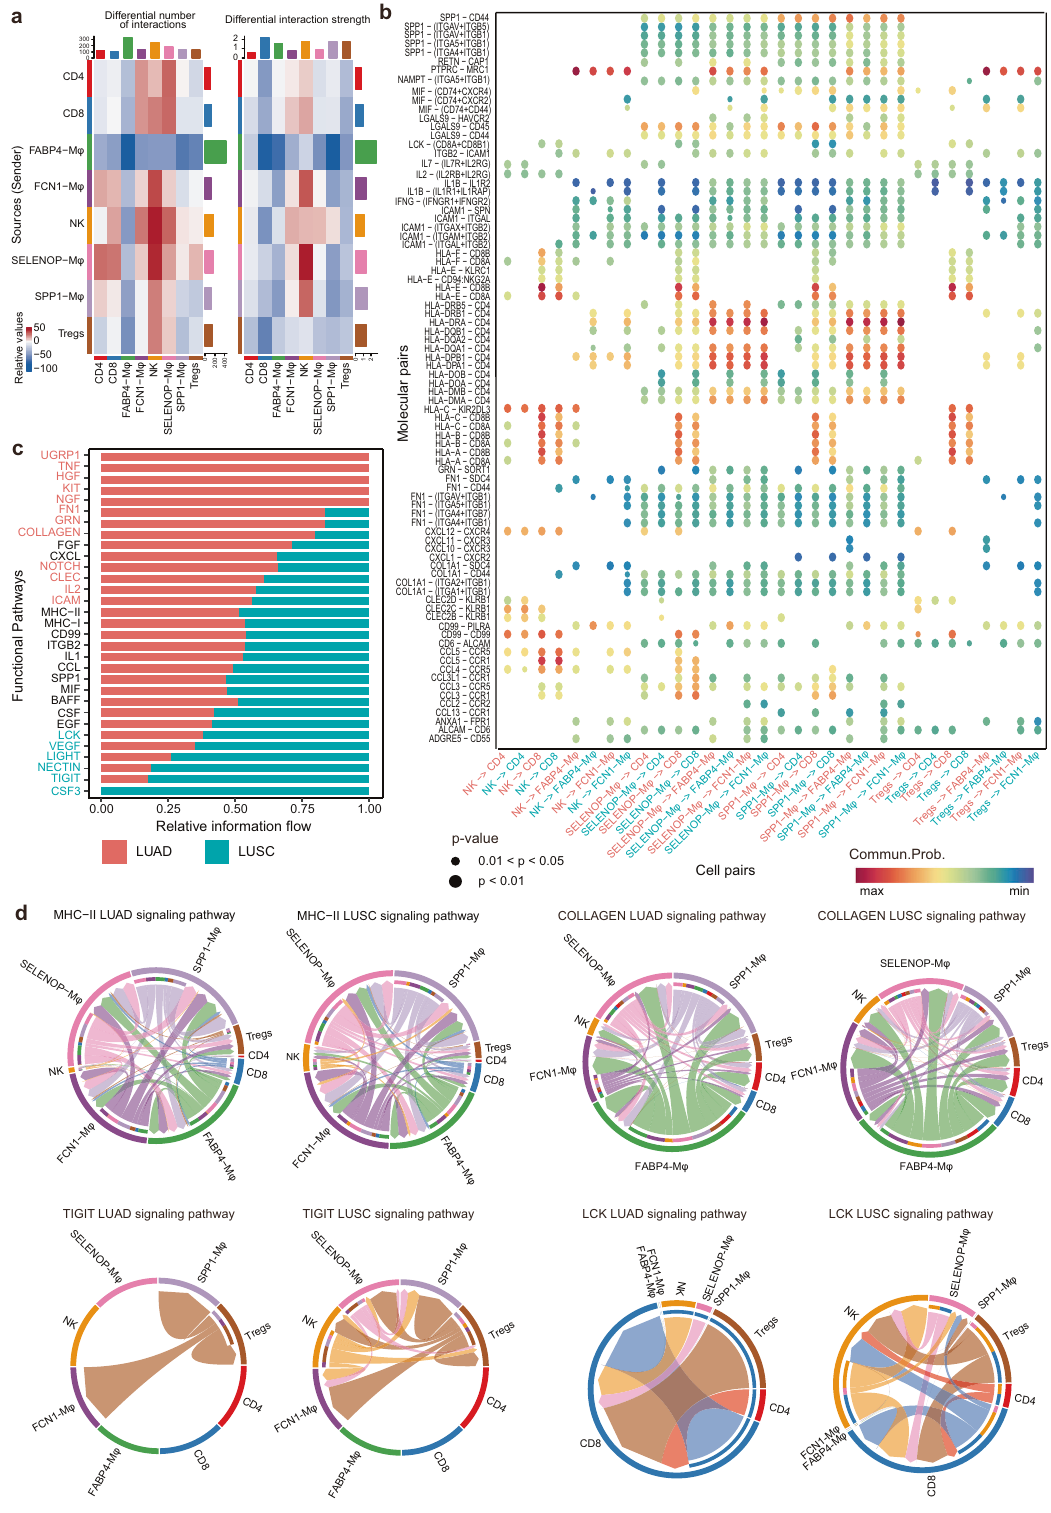
their functional similarity (Fig. 7c and Supplementary Fig. 8c). The various pathways were clustered into 4 groups: Cluster1 to Cluster4, and the signaling pathways belonging to Cluster1 were mainly from LUAD, such as UGRP1, TNF, and HGF. We also identi fi ed some signaling pathways enriched in LUSC,